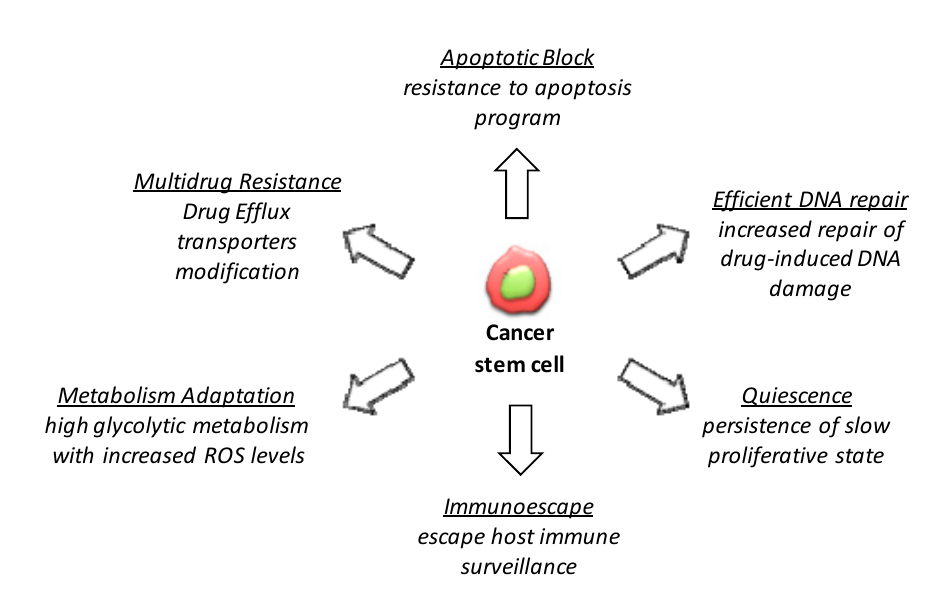
Figure 4. CSCs model of drug resistance: CSCs features mostly responsible for drug resistance.